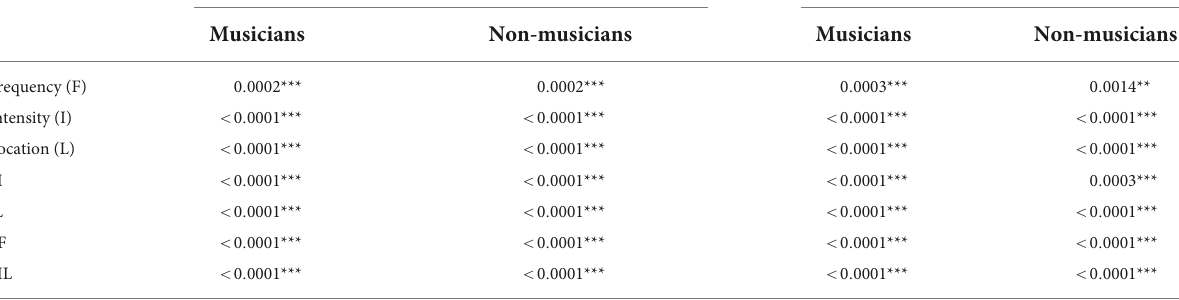
TABLE 2 Magnetic mismatch negativity response